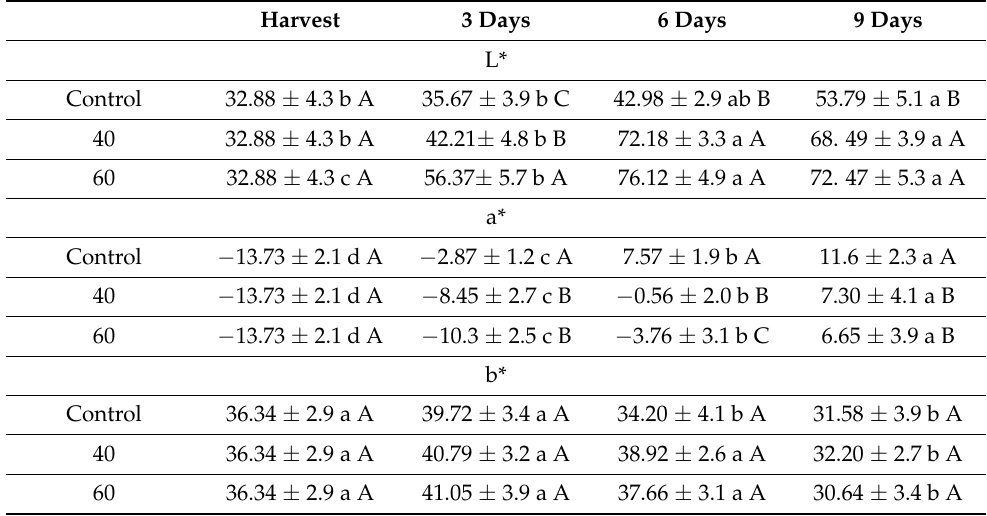
Table 2. Effect of eugenol doses on the color CieLab parameters (L*, a*, b*) in Raf tomato fruits. Harvest 3